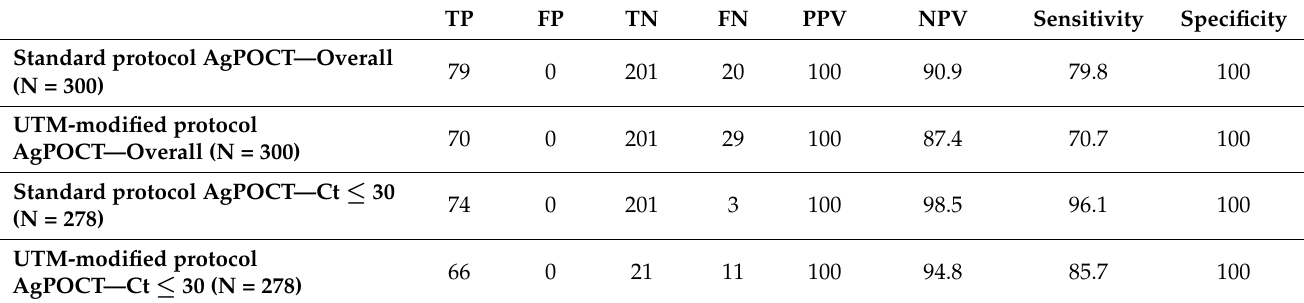
Table 1. Comparison of the diagnostic accuracy of standard and UTM-modified protocol for rapid antigen testing. Data are expressed as %